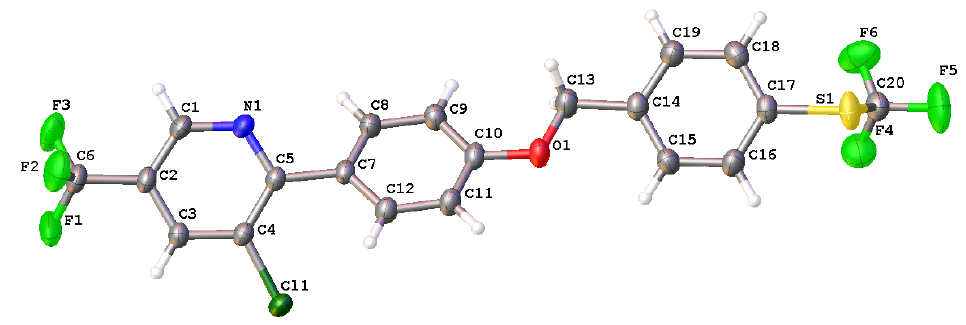
Figure 2. The X-ray crystal structure of compound 5a .